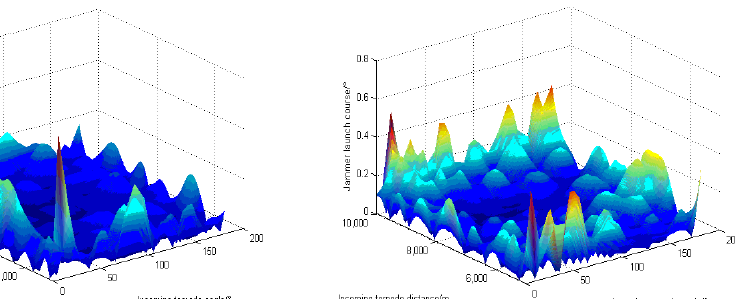
Figure 15. The difference between the typical GA ‐ BP neural network’s test output and the actual output.